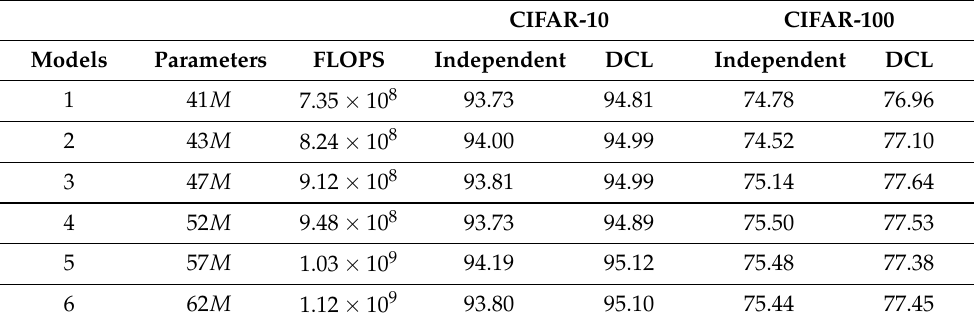
Table 2. Evaluation of DCL and independent training on CIFAR-10 and CIFAR-100 using a chain of six random models.